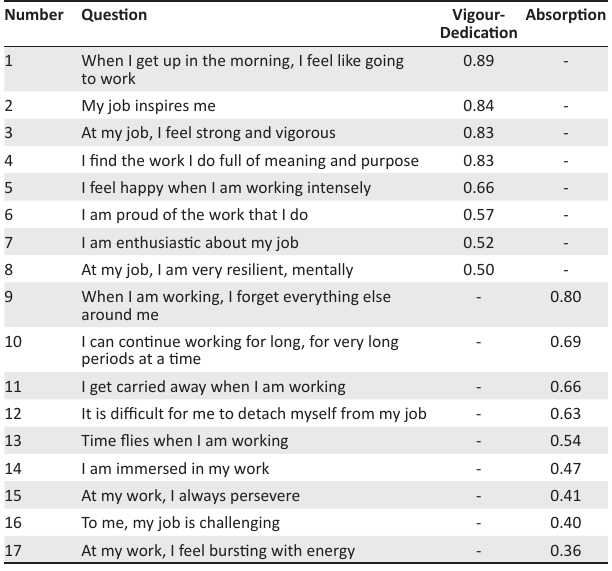
TABLE 2: The results of factor loadings of work engagement.